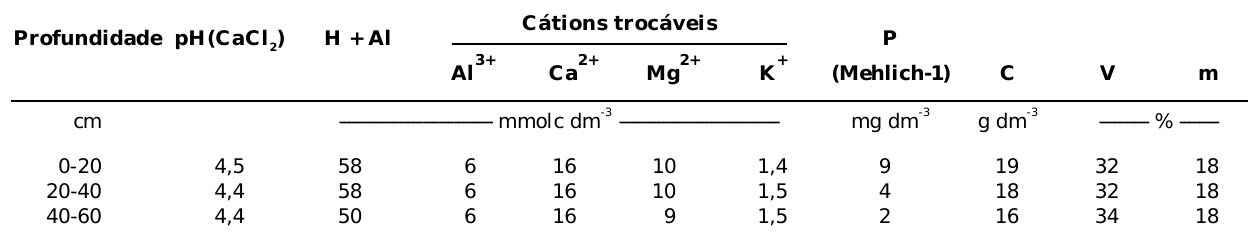
Quadro 1. Resultados de análise química do solo antes da instalação do experimento em diferentes